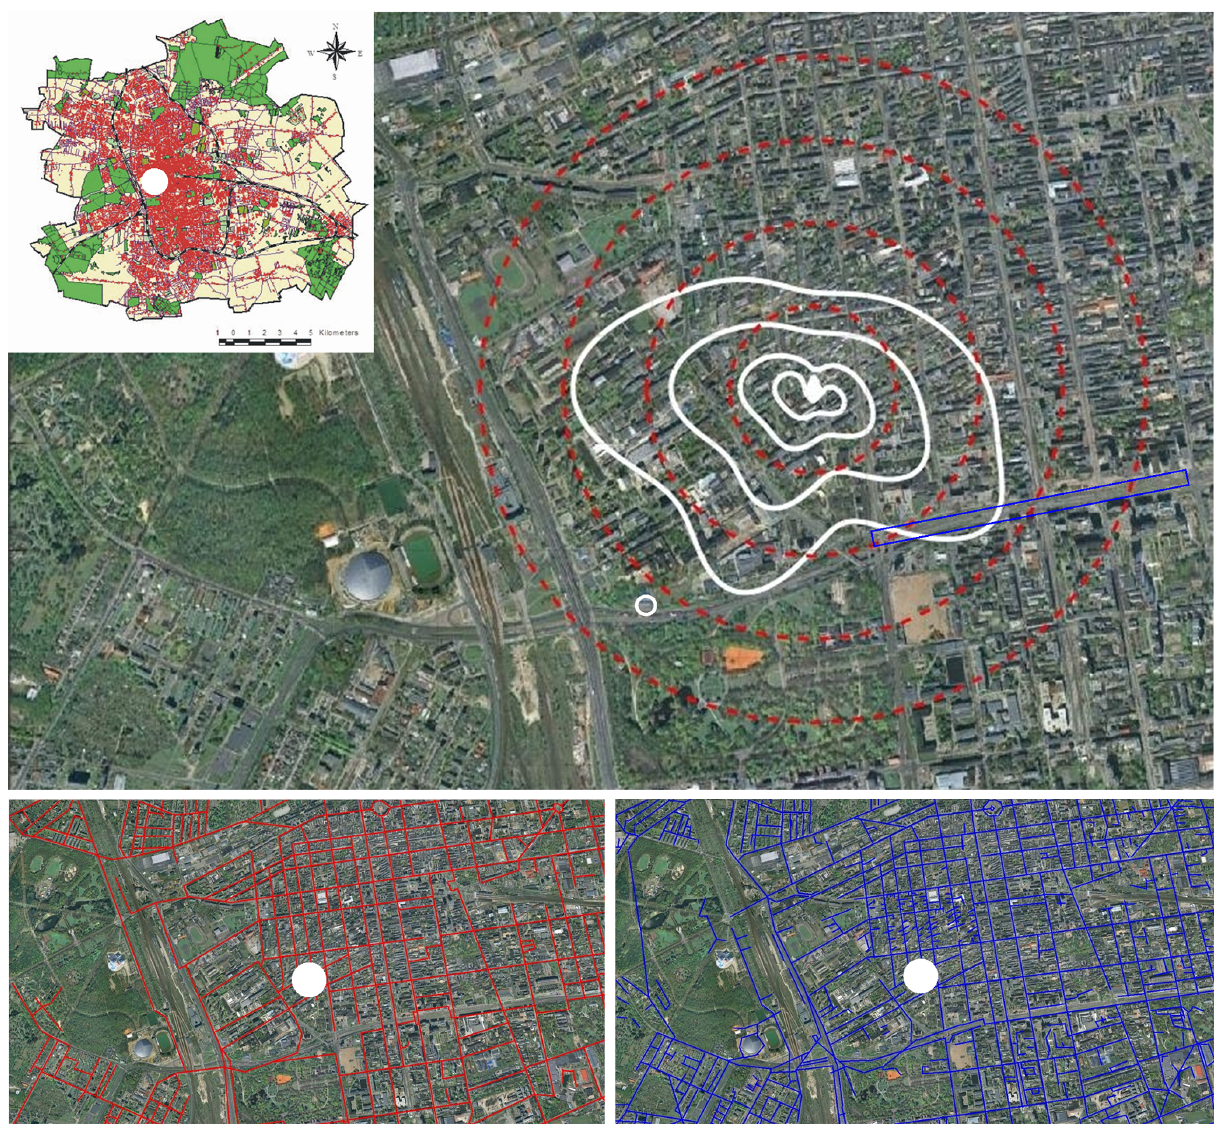
Figure 1. The western part of the centre of Łód´z (top). Solid white lines indicate the source area with P = 25, 50, 75 and 90%, calculated for the turbulent fluxes measured at 10:00 to 14:00 during unstable stratification (all available data from the period July 2013–August 2015). The dashed red lines represent 250, 500, 750 and 1000m distances from the measurement point. The white circle indicates liquid petroleum gas station and the blue rectangle indicates area of road tunnel construction. Bottom figures show spatial distribution of gas network (bottom left) and sewage system (bottom right) in the neighbourhood of the measurement site (white dots). Schemes are based on data from